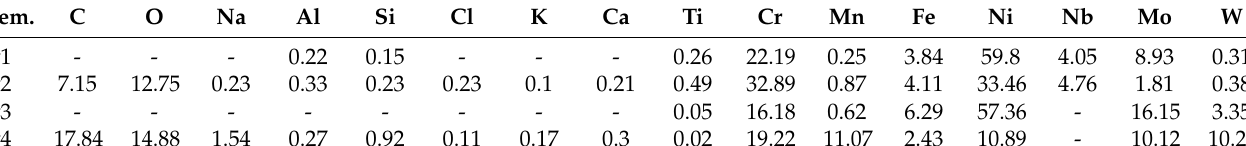
Table 1. Chemical composition testing results by EDS of after heat treatment specimens (wt.%). Elem.